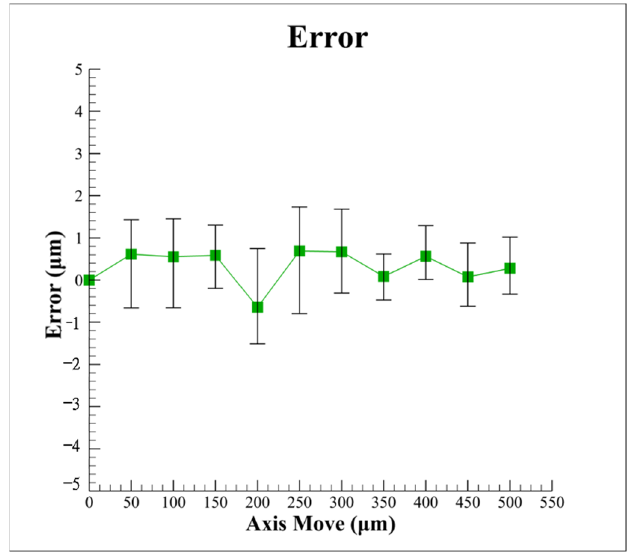
Figure 13. Experimental results for autofocusing accuracy with different defocus distances by using proposed algorithm.